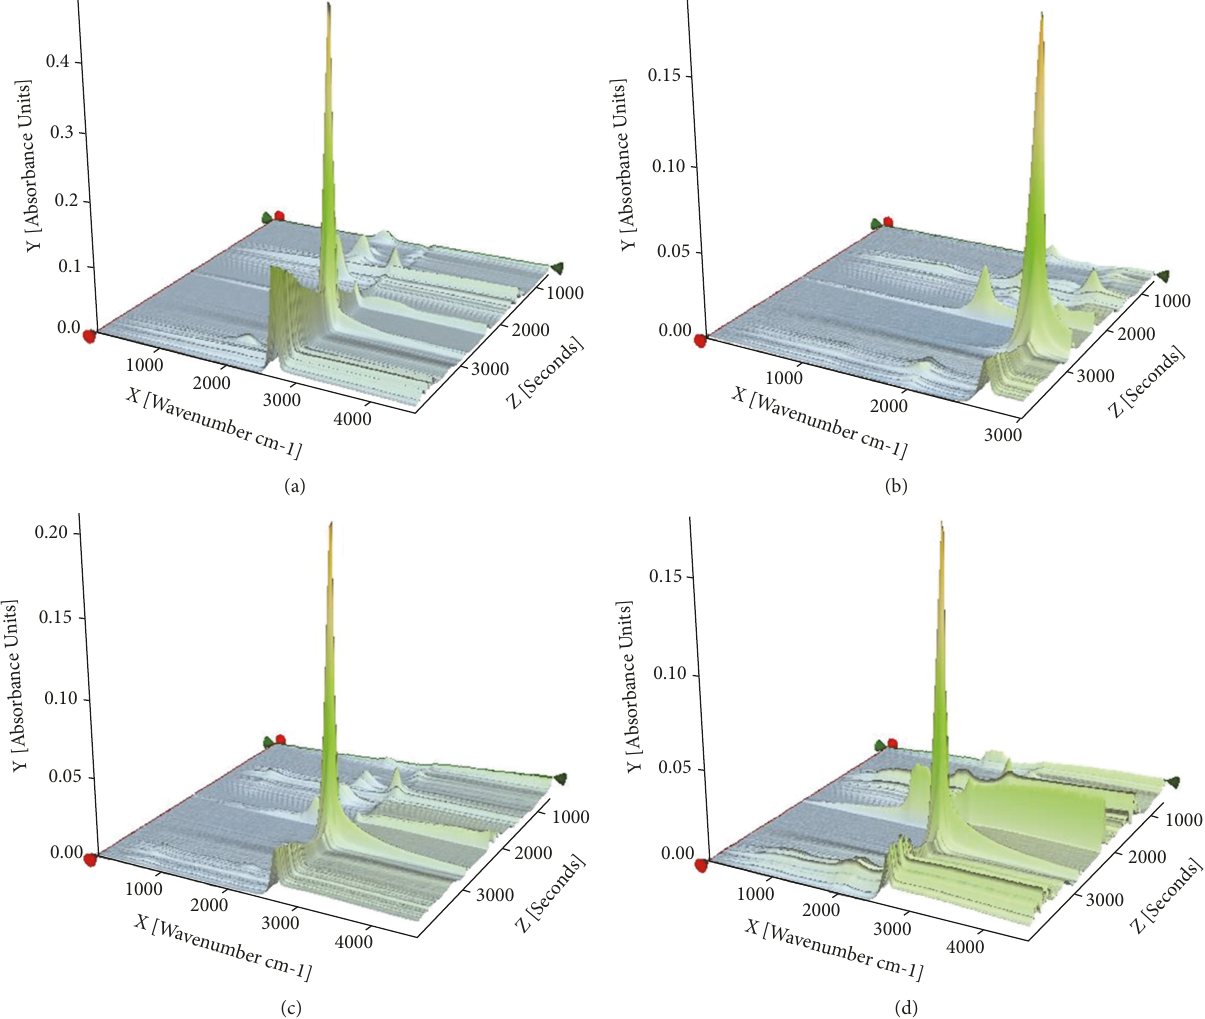
Figure 11: 3D TG-FTIR spectra of pyrolysis products of the composites during the thermal degradation: (a) EVA0, (b) EVA1, (c) EVA2, and (d)